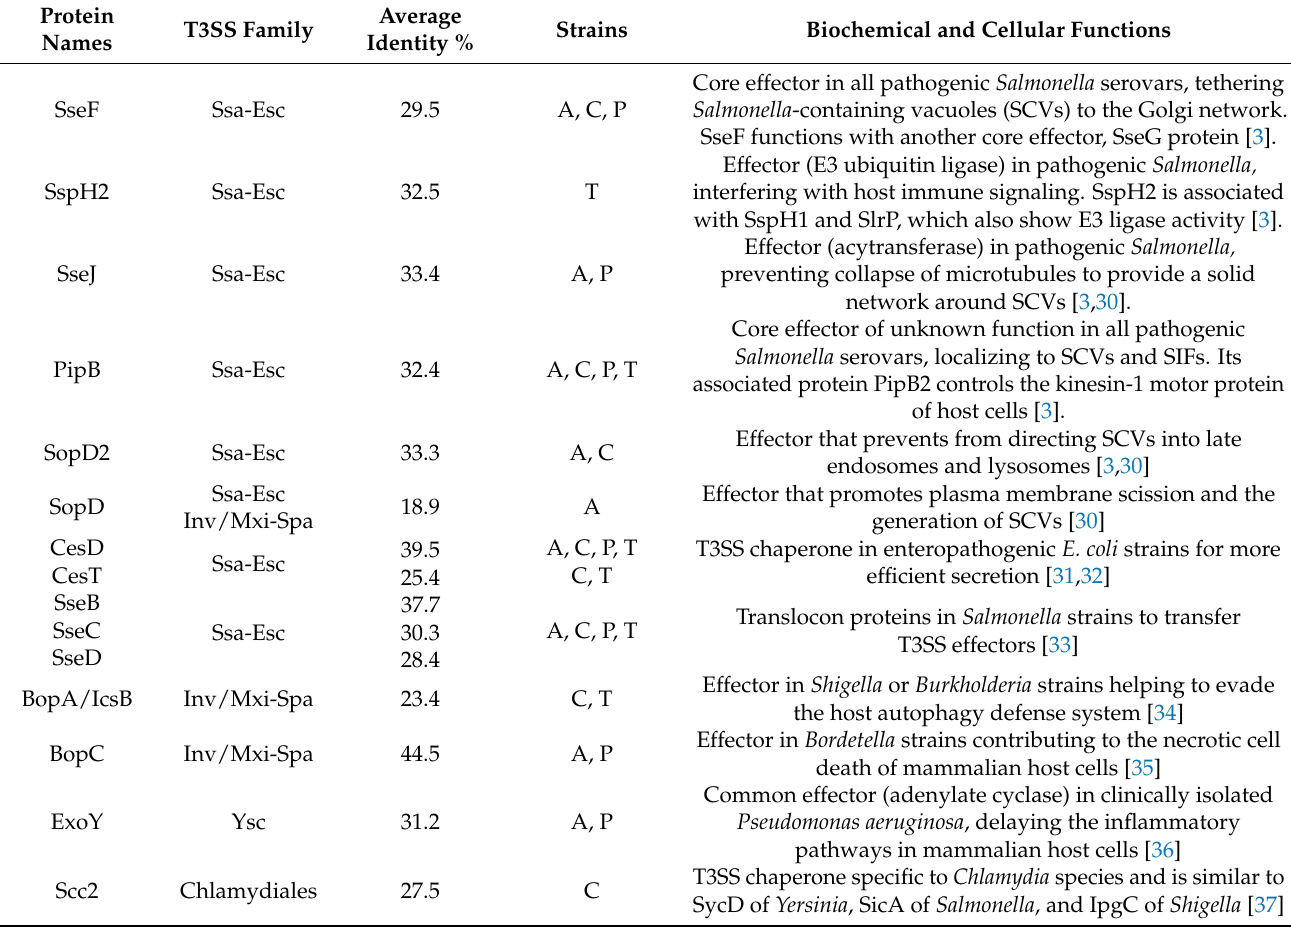
T3SS3 clusters, and 35 groups showed significant hits (E-value: <1 × 10 − 3 ). In order to mini- mize the number of false positives, the protein sequences of Aliivibrio fischeri and Escherichia coli K-12 were used as the negative control (see Methods). The combination of BLASTp searches of the 35 homologous groups against both 205 positive- and the negative-control datasets identified 14 true-positive protein groups (Table 2 and Supplementary Table S5). Eleven out of the 14 groups were similar to effectors, translocons, or chaperones in the Ssa-Esc family, just like the core T3SS proteins of T3SS3. The remaining few sequences were common with proteins in the Ysc or Inv/Mxi-Spa families. Salmonella translocons (SseB, SseC, SseD), EPEC/EHEC chaperone (CesD), and some core effectors in Salmonella (SseF, PipB) were conserved across Vib-T3SS3 strains. Not all the core Salmonella effectors, however, were detected in Vib-T3SS3 clusters in our analysis. For example, Jennings et al. defined seven core Salmonella effectors shared by all serovars (SseF, SseG, PipB, SteA, SteD and PipB2) [3], but the majority were completely absent from these Vibrio species (Table 2). Table 2. Putative T3SS3 effectors, translocons, and chaperones. The ‘Average identity’ column shows amino acid conservation rates in the Vib-T3SS3 strains. The letters in the ‘Strains’ column indicate the presence of a homolog (A: V. aquimaris strain THAF100; C: V. coralliilyticus OCN008; P: V. pectenicida 99-46-Y; and T: Vibrio sp.